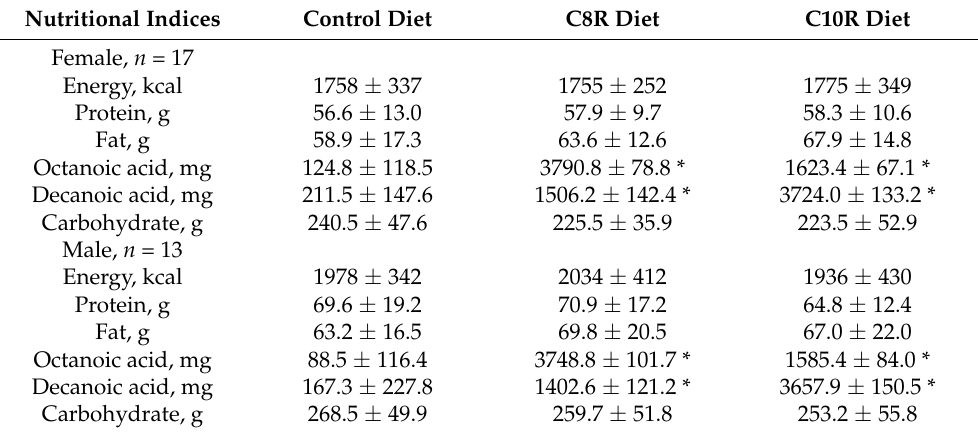
Table 3. Means of dietary intake per day, during the five days before each exercise trial in the present